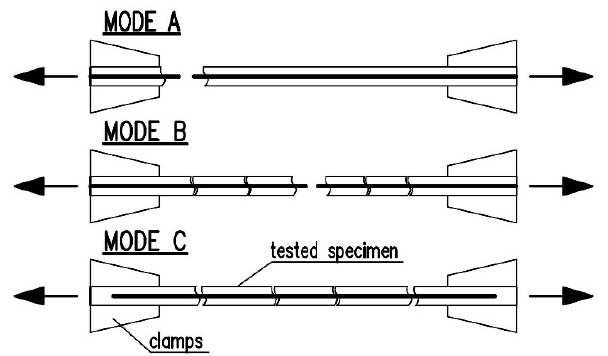
Figure 4. Failure modes of FRCM materials under direct tension.